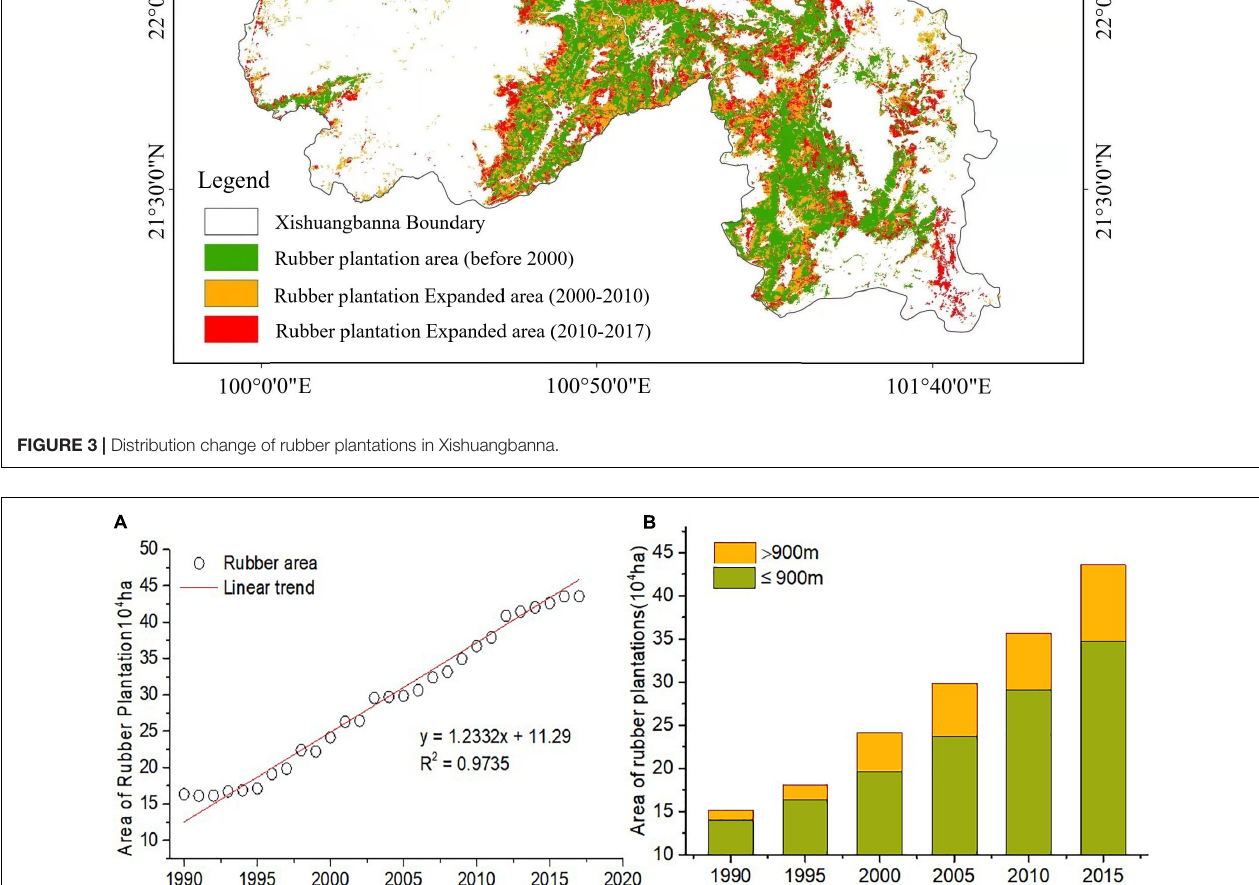
FIGURE 4 | Distribution of rubber plantation area (A) and altitude (B) in Xishuangbanna.